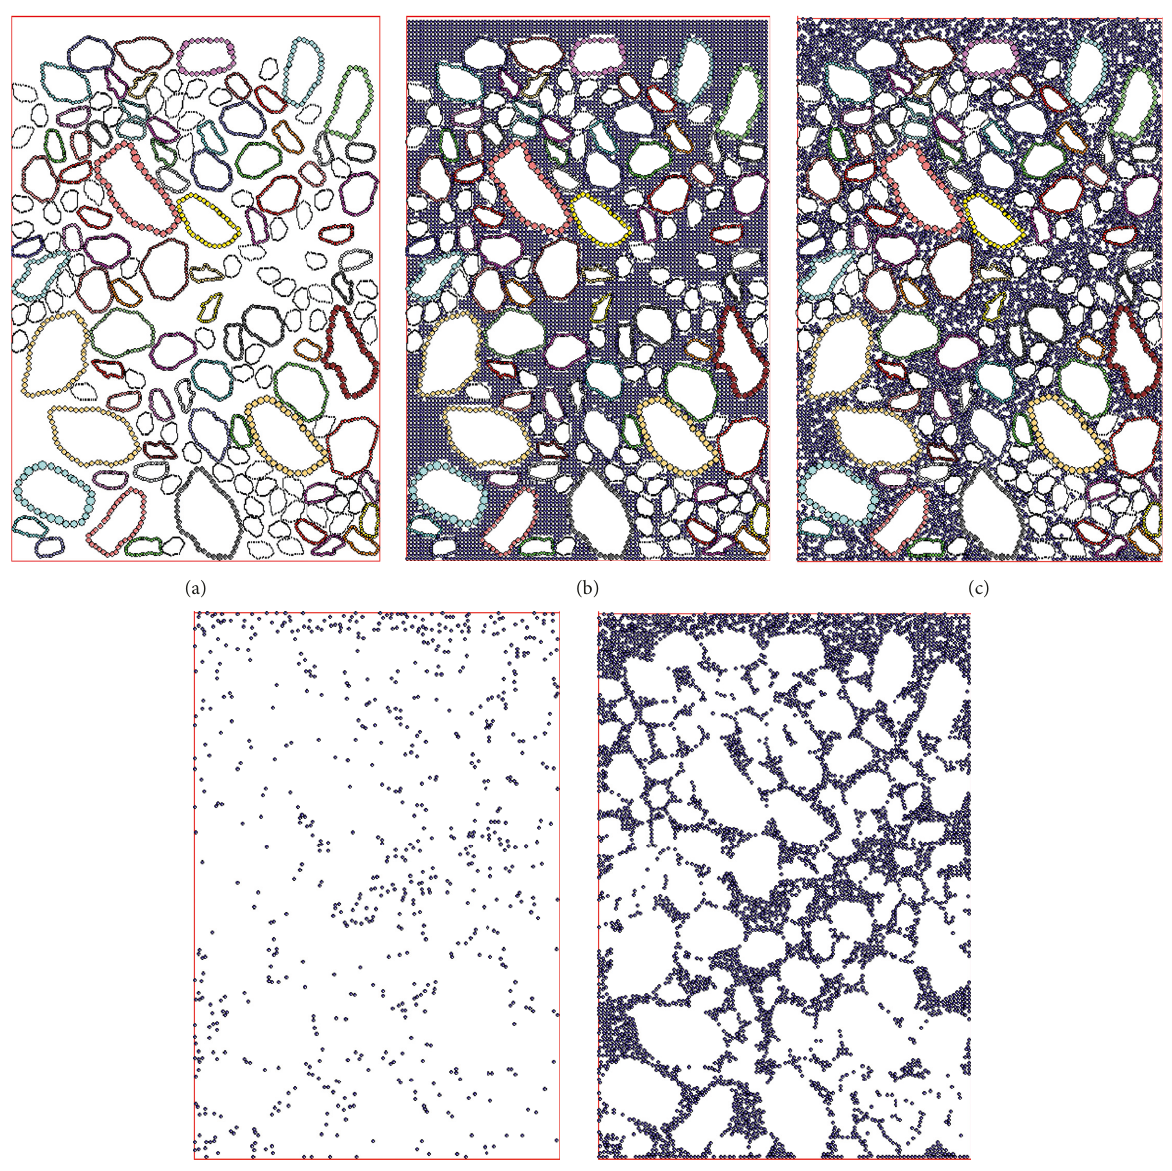
Figure 12: Modeling process of virtual asphalt mixtures: (a) aggregate skeleton; (b) uniform balls filling; (c) virtual asphalt mixture; (d) voids modeling; (e) asphalt mastic